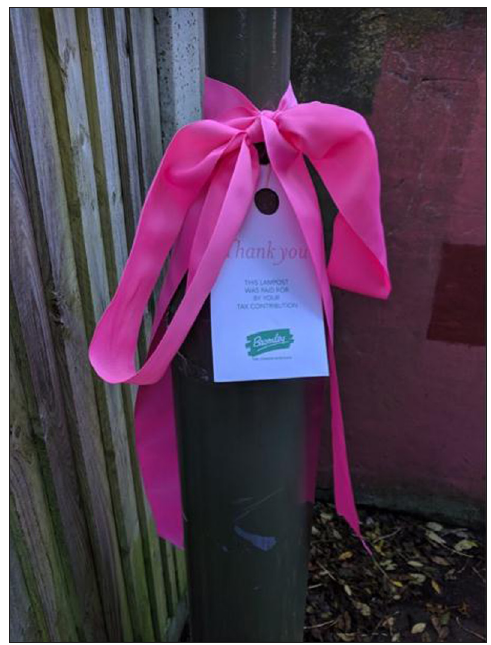
Figure 1: Advert used in experiments